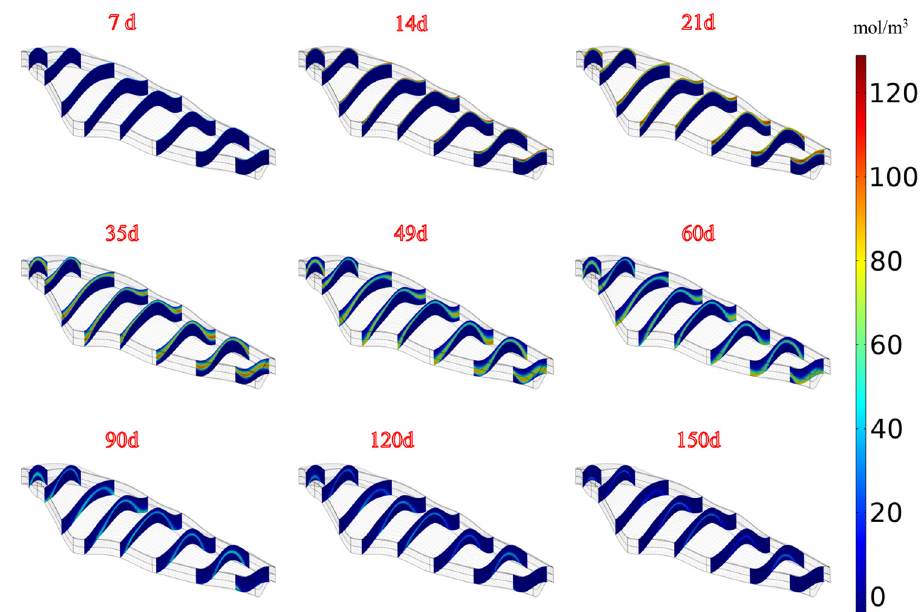
Figure 14. Cloud diagram of rare earth ion migration in the stope.